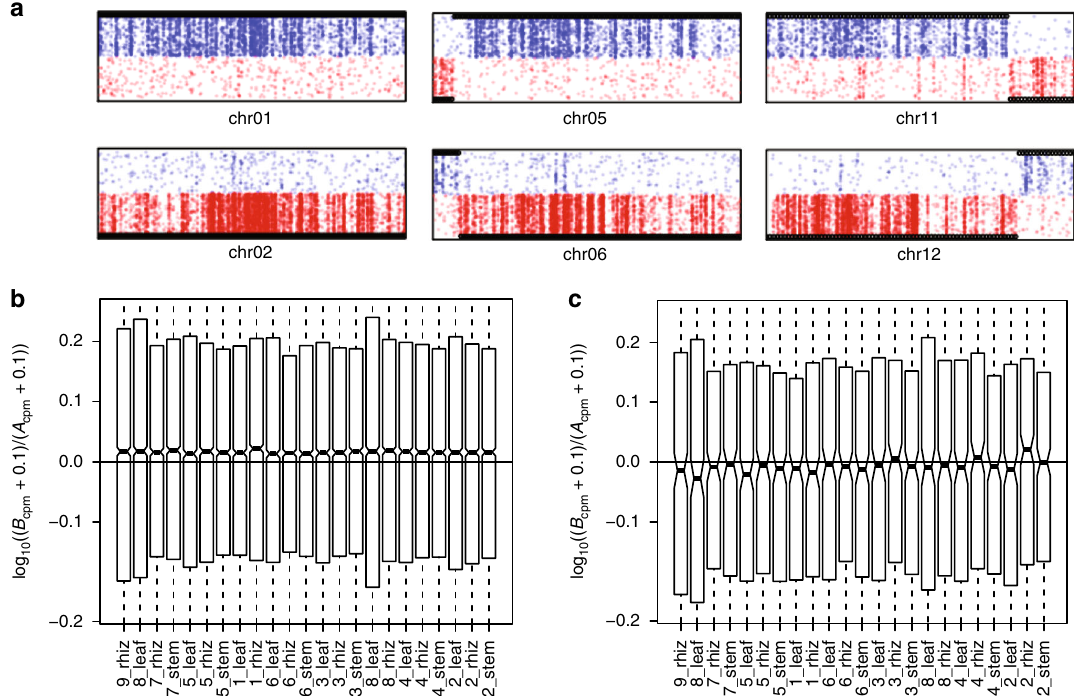
Fig. 3 Post-allotetraploidy reciprocal exchanges. a Example of a chromosome pair without reciprocal exchange (chr01 – chr02), and two chromosome pairs with distal reciprocal exchanges (chr05 – chr06 and chr11 – chr12). Red and blue dots represent occurrences of subgenome-speci fi c 13-mers. Black bars identify A and B ancestry inferred from a Hidden Markov Model (Supplementary Note 7.2). b Relative expression of homeologous gene pairs. Across tissues and seasonal sampling times, there is a 3.8% median bias toward the expression of the B member of the pair. c Homeologous gene pairs within reciprocally exchanged regions show the expression bias of their ancestral location. Source Data underlying Fig. 3b, c are provided in the Source Data fi